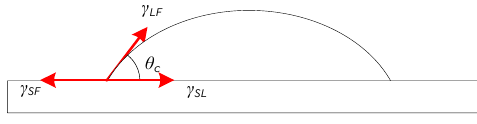
Figure 3. Diagrammatic sketch of Young’s equation.